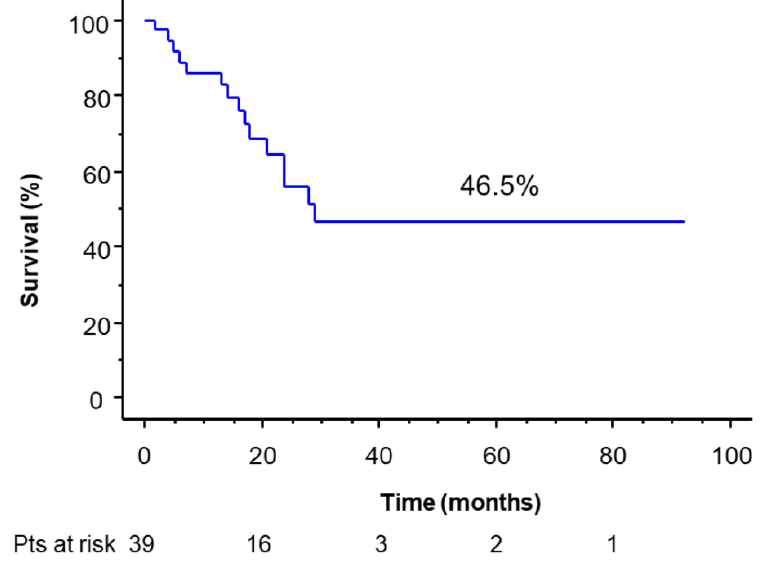
Figure 2. Disease free interval of the operated patients.